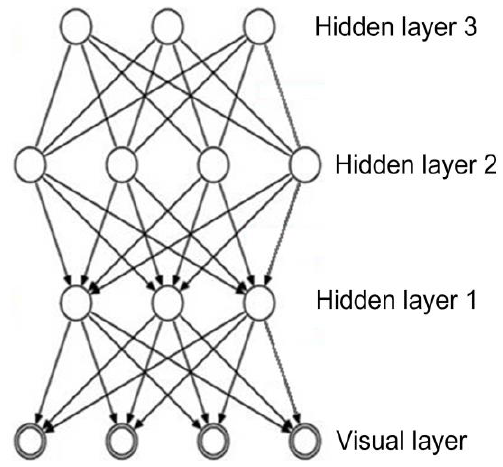
Figure 2. Structure of deep belief networks (DBN) model.